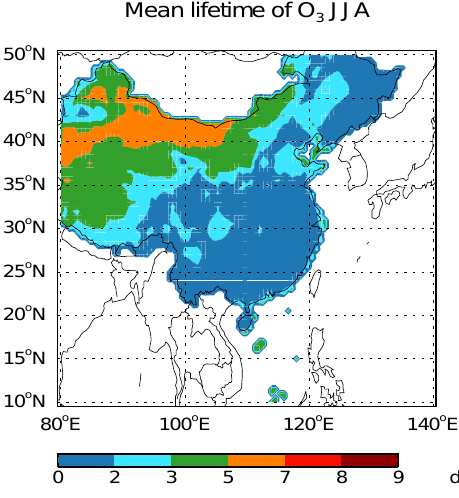
Fig. 8. Mean lifetime of ozone in the summer